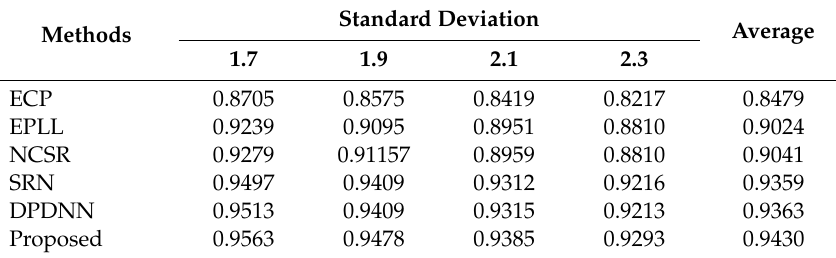
Table 4. The SSIM results of the deblurred images for all evaluated methods.